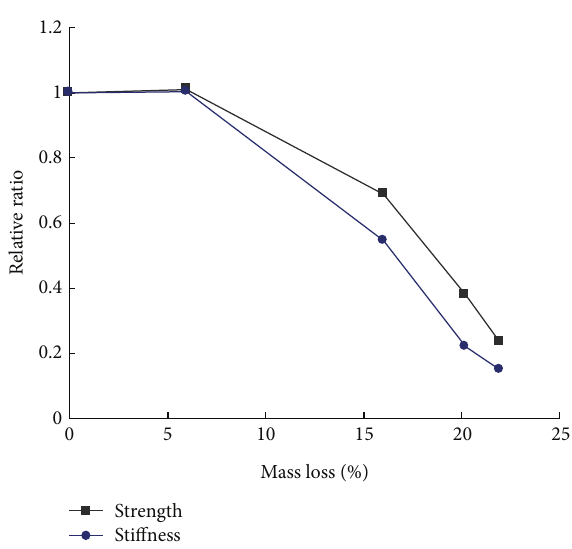
Figure 8: Relationship of strength and stiffness to mass